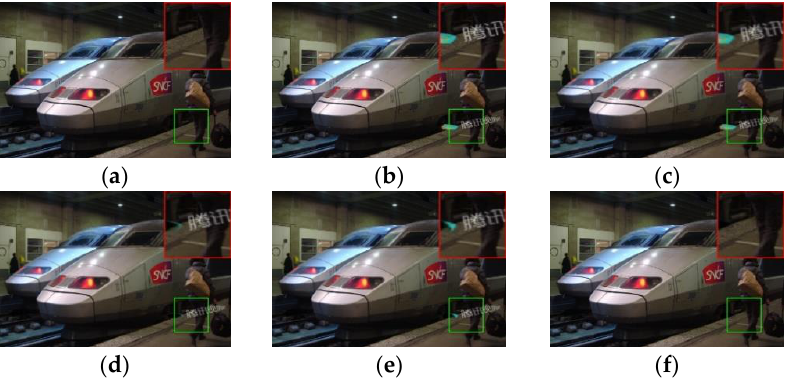
Figure 4. Visual effects of different methods with a transparency rate of 0.6 for image watermark removal. ( a ) Original image, ( b ) watermark image, ( c ) DnCNN, ( d ) FFDNet, ( e ) U-net and ( f ) IWRU-net (ours).